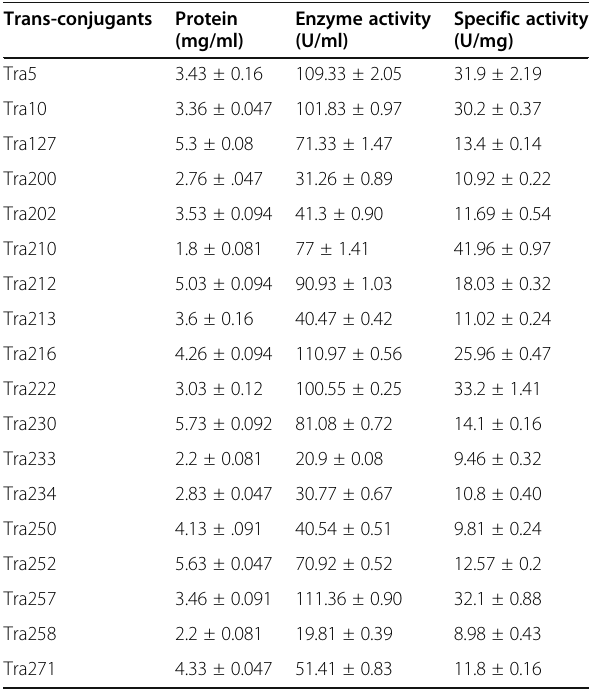
Table 1 Screening of β -galactosidase activity Trans-conjugants Protein